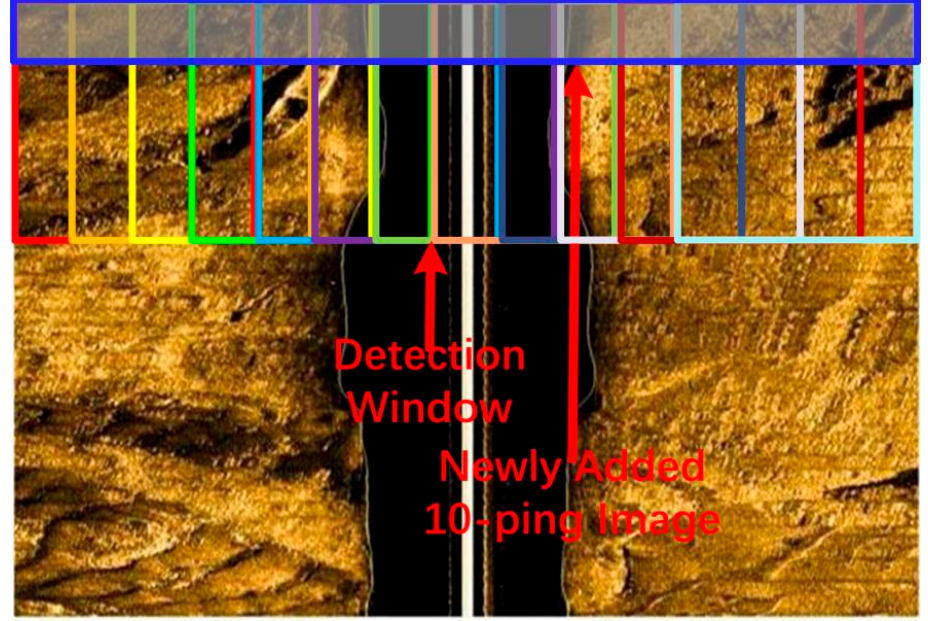
Figure 11. Real-time target detection strategy.